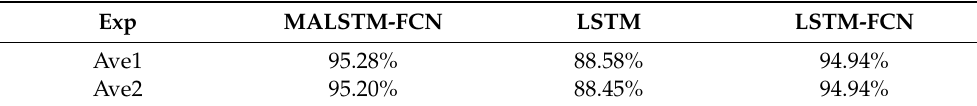
Table 8. Accuracy